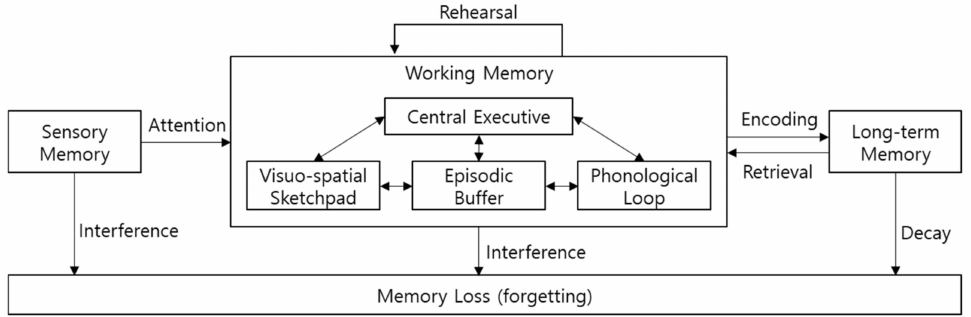
Figure 2. Alan Baddeley’s working memory model [12] with Atkinson and Shiffrin’s multi-store memory model